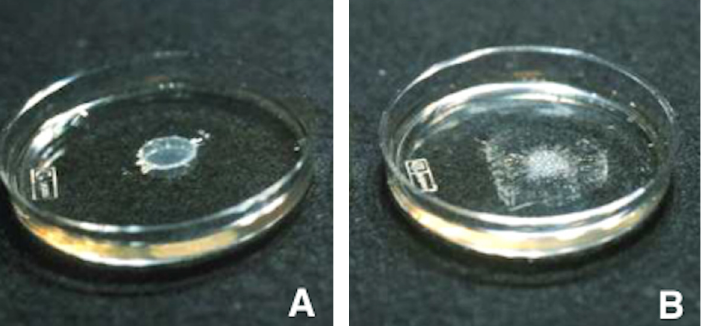
Figure 3. Example of extension of polymerization of glue according the lipiodol ratio. ( A ) Glue/lipiodol mixture in a 1:1 ratio (50% NBCA). ( B ) On the left glue/lipiodol mixture in a 1:4 ratio (20% NBCA) showing delayed polymerization with more extensive cast in surface. Table 1. Cyanoacrylate glues: types and mechanisms of action.